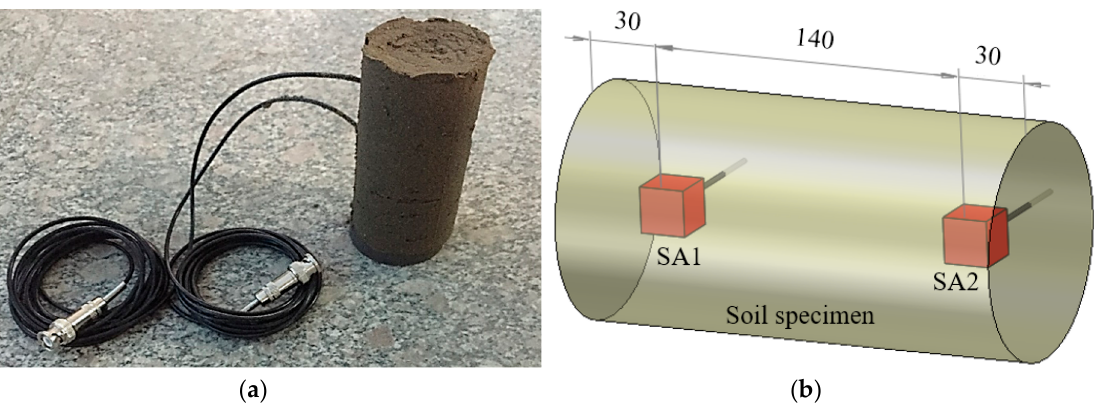
Figure 3. Sandy soil specimen and the location of SAs in the specimen. ( a ) Sandy soil specimen, ( b ) Location of the SAs in the sandy soil specimen.